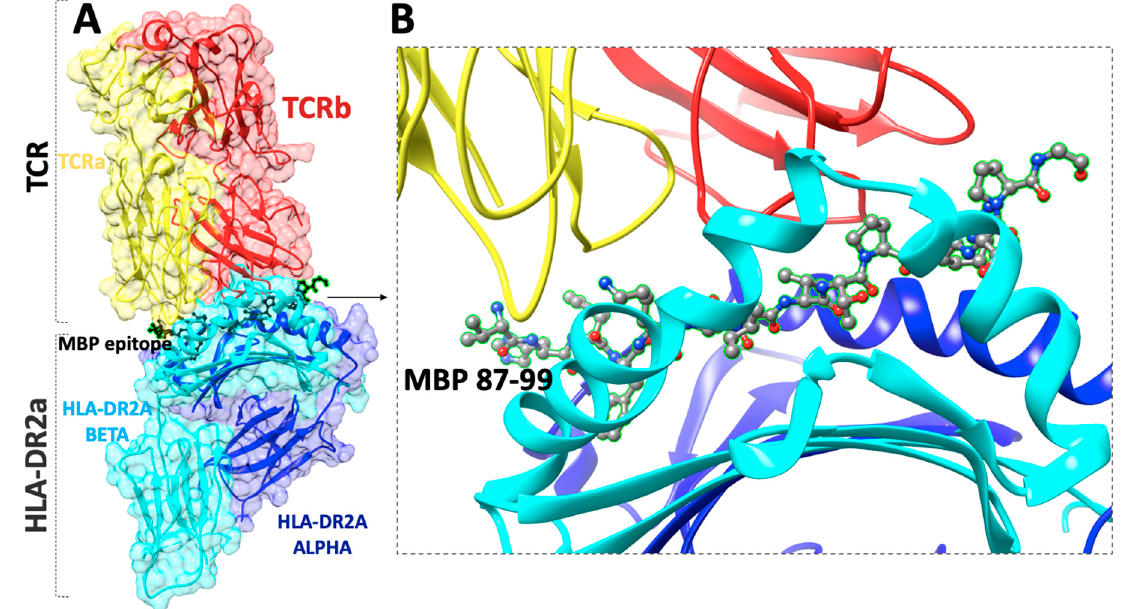
Figure 3. ( Α ) The X-ray structure (pdb: 1ZGL) of a human autoimmune TCR bound to a myelin basic protein self-peptide (MBP 87–99 ) and a multiple sclerosis-associated MHC class II molecule (HLA-DR2a) , ( Β ) close view of the docking site of (MBP 87–99 ) peptide.